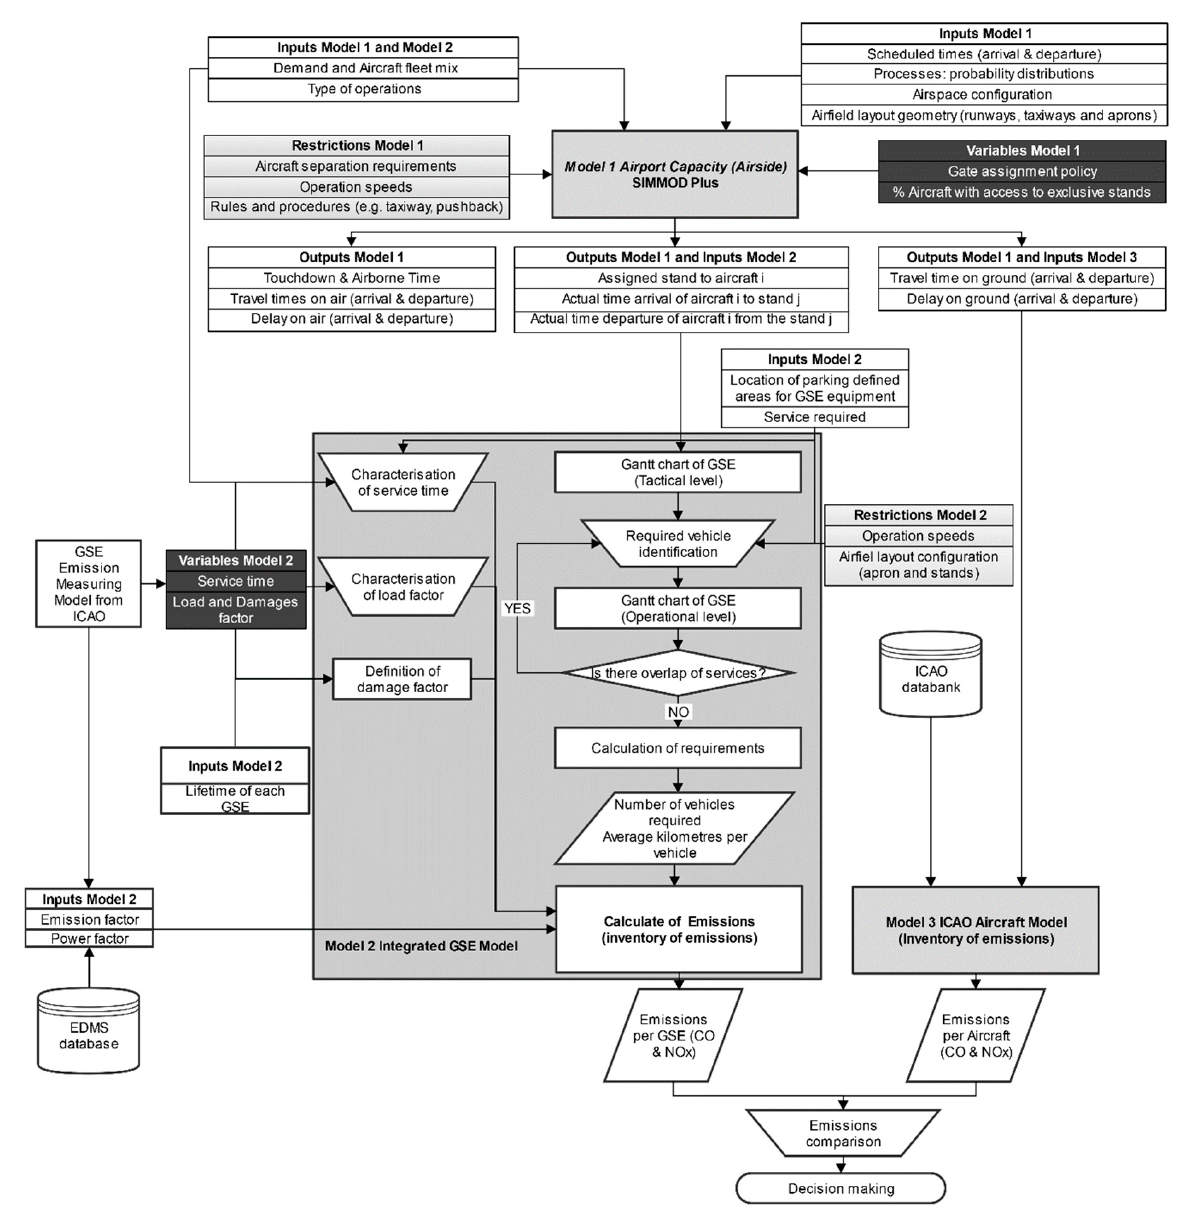
Figure 1. General methodology diagram.